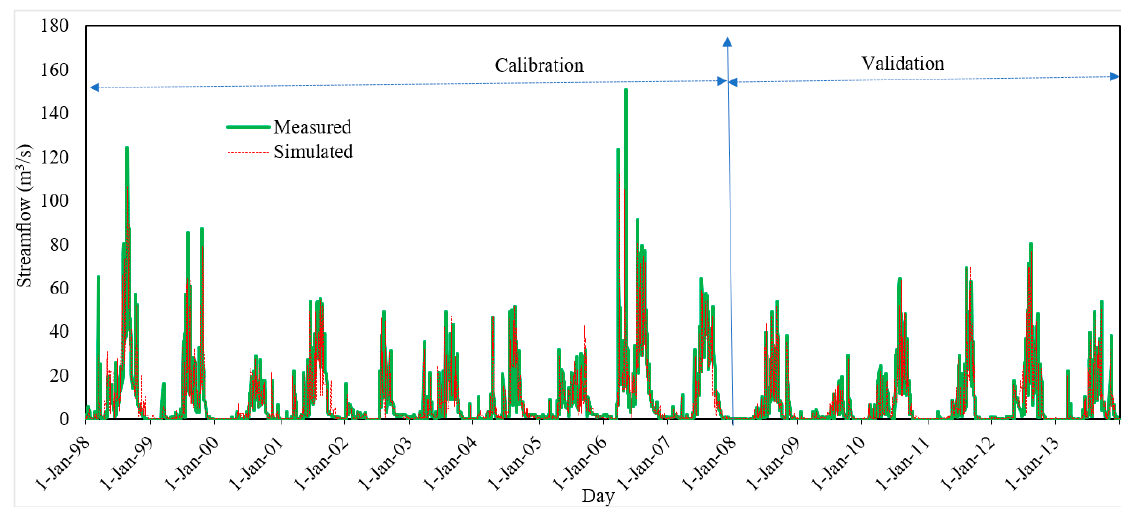
Figure 4. Daily stream flow calibration and validation at Abura gauging station.